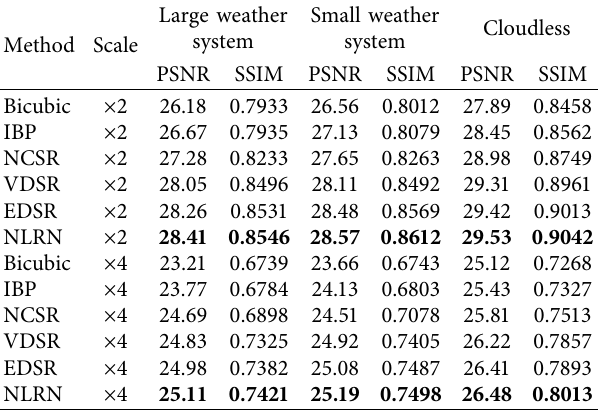
The best results are in bold.